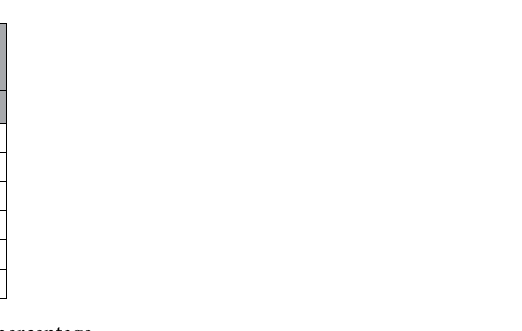
Table 1. Rate of change in PA amplitude and lysis percentage.